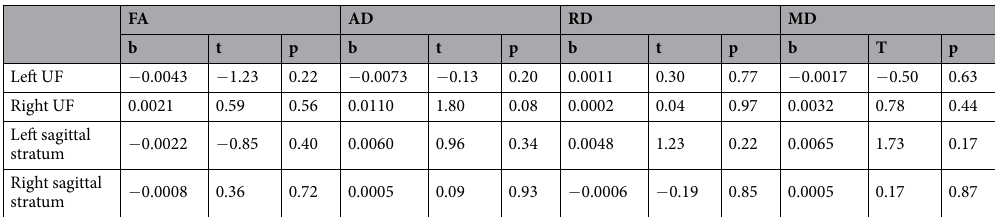
Table 3. Individual-level linear regression of neuroimaging measures on anxiety a . a Linear regression includes covariates age and sex; standard errors account for clustering within twin pairs.